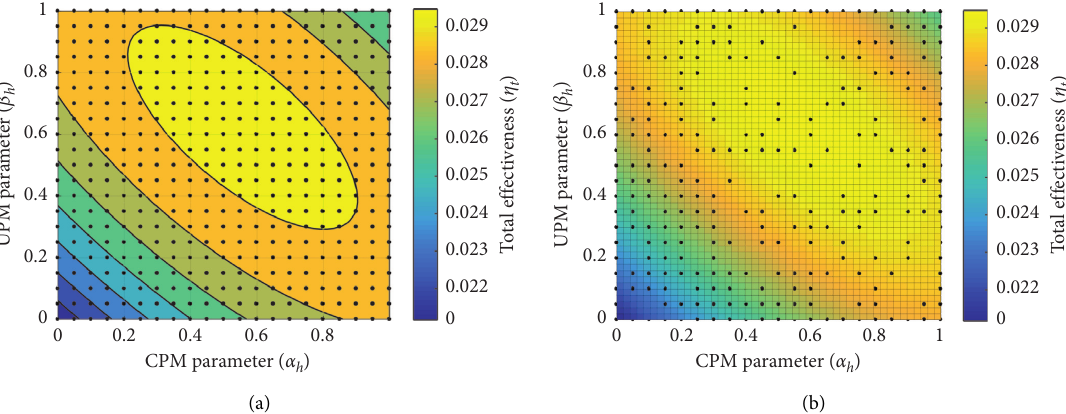
Figure 8: Effect of hunters’ CPM and UPM on the HGMP’s effectiveness η and (b) polynomial curve